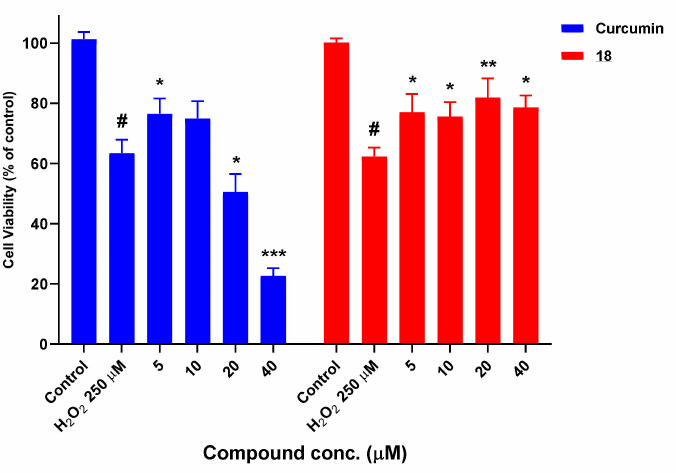
Figure 11. Neuroprotection effect of curcumin and compound 18 against H 2 O 2 -induced cytotoxicity in SH-SY5Y cells. Cell viabilities were determined by Calcein–AM assay with fluorometric detection. Compounds were administered at different concentrations for 24 h prior to H 2 O 2 250 µ M treatment for another 24 h. Data are presented as the Mean ± SEM of four independent experiments carried out in quadruplicate. # p < 0.001 vs. vehicle- treated control. * p < 0.05, ** p < 0.01, *** p < 0.001 vs. only with H 2 O 2 -treated cells.